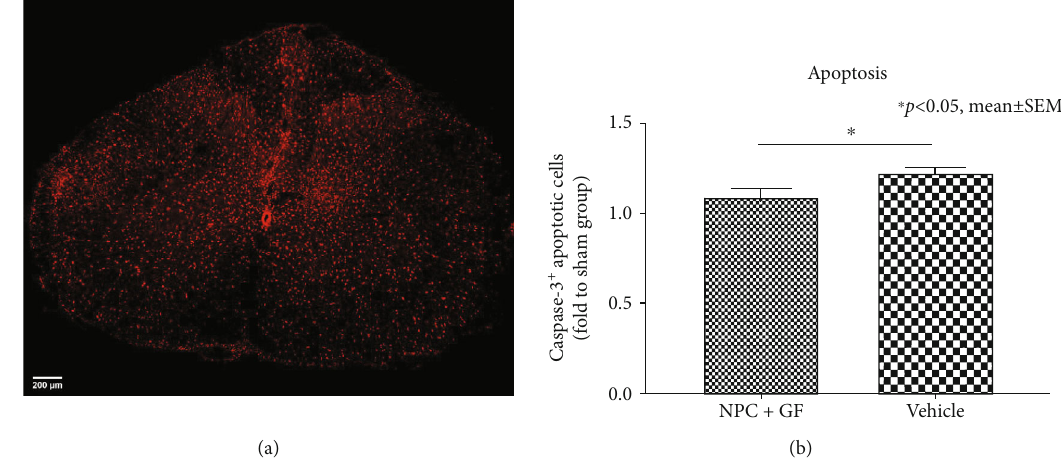
Figure 10: In vivo apoptotic cell death 8 weeks after cervical SCI. (a) Spinal cord cross-section stained for Caspase-3 (red), a marker for ongoing apoptosis. (b) Quanti fi cation of Caspase-3 + , apoptotic cells in the injured spinal cord in proportion to (fold to) the sham